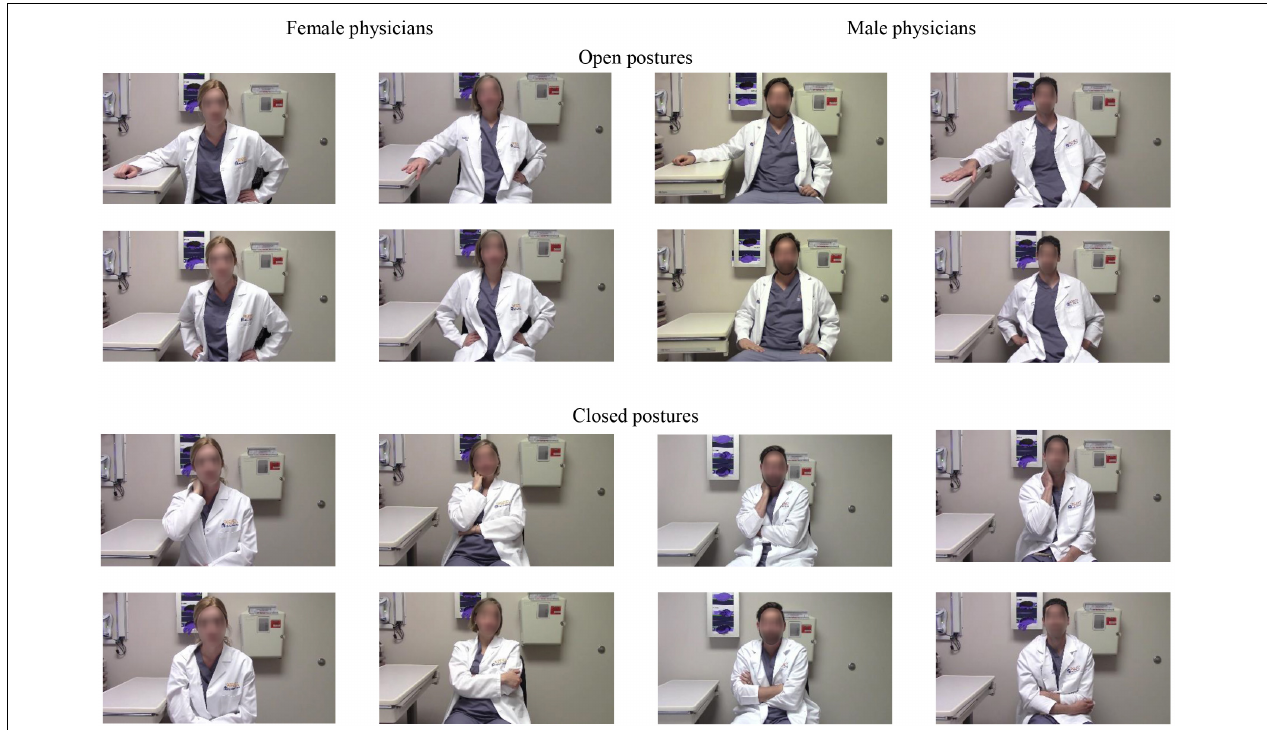
FIGURE 1 | Picture stimuli showing two male and two female physician actors, each in two open and closed poses. The stills were taken from the video stimuli used in the study by Forkin et al. (2019) with the permission of the authors.